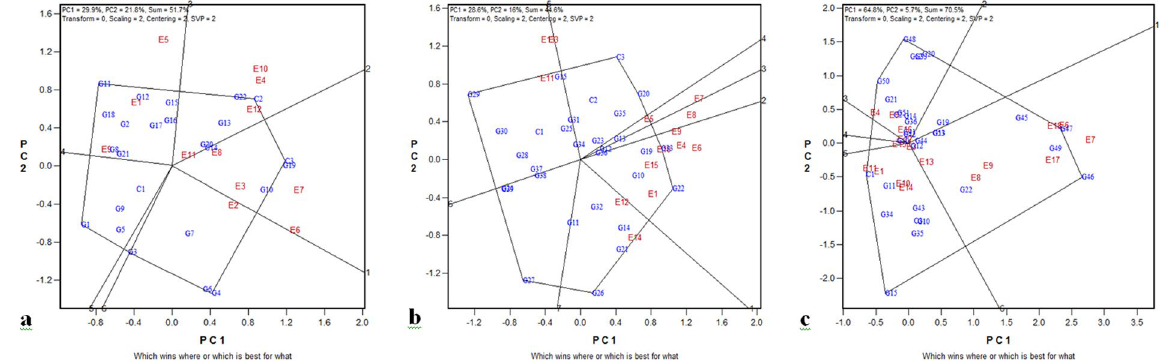
Figure 3. GGE biplot identification of winning genotypes and their related mega-environments in ( a ) 2011, ( b ) 2012, and ( c ) 2013.